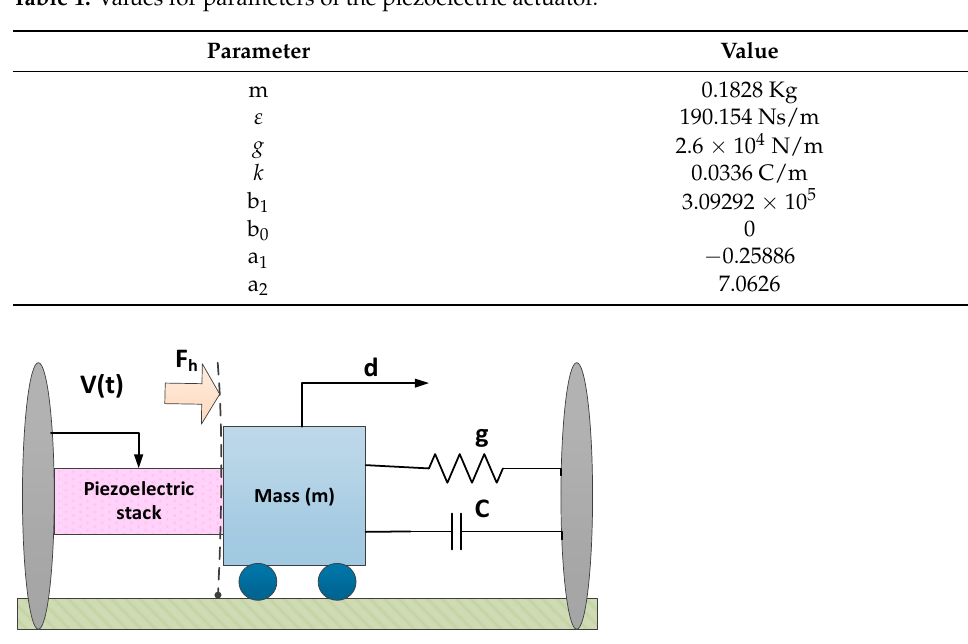
Table 1. Values for parameters of the piezoelectric actuator.